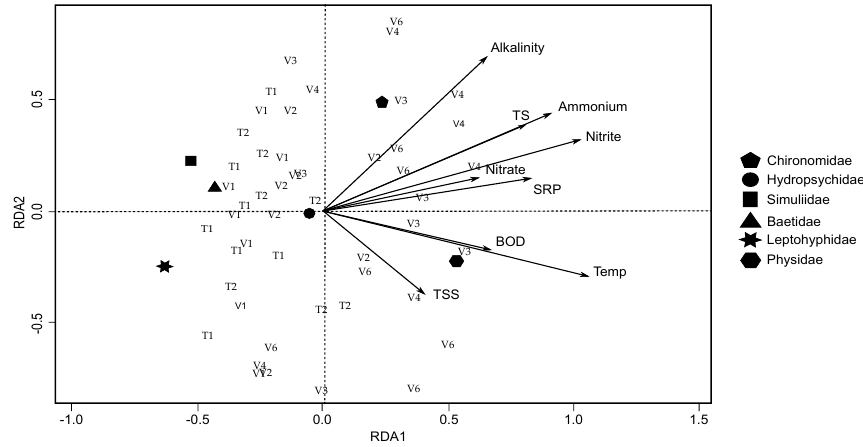
Figure 4. Biplot of the RDA results in the study area, including water quality variables and sample